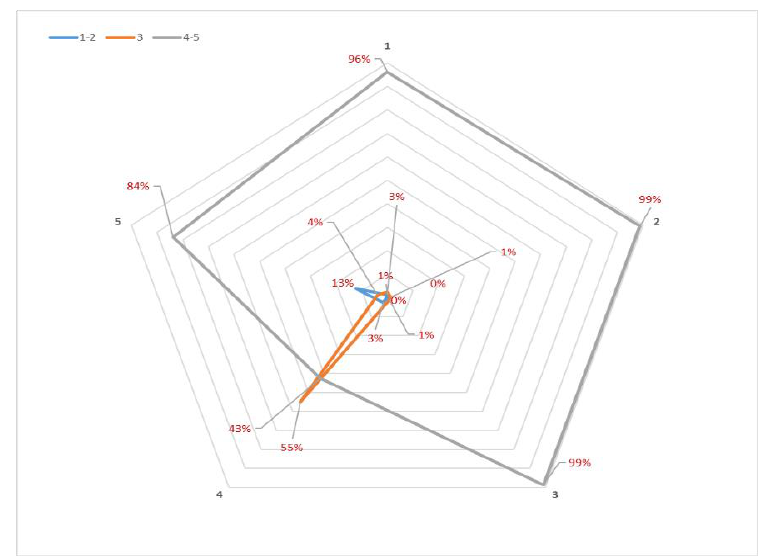
Figure 3: Sample A Investigation Prior to the Spread of Covid-19